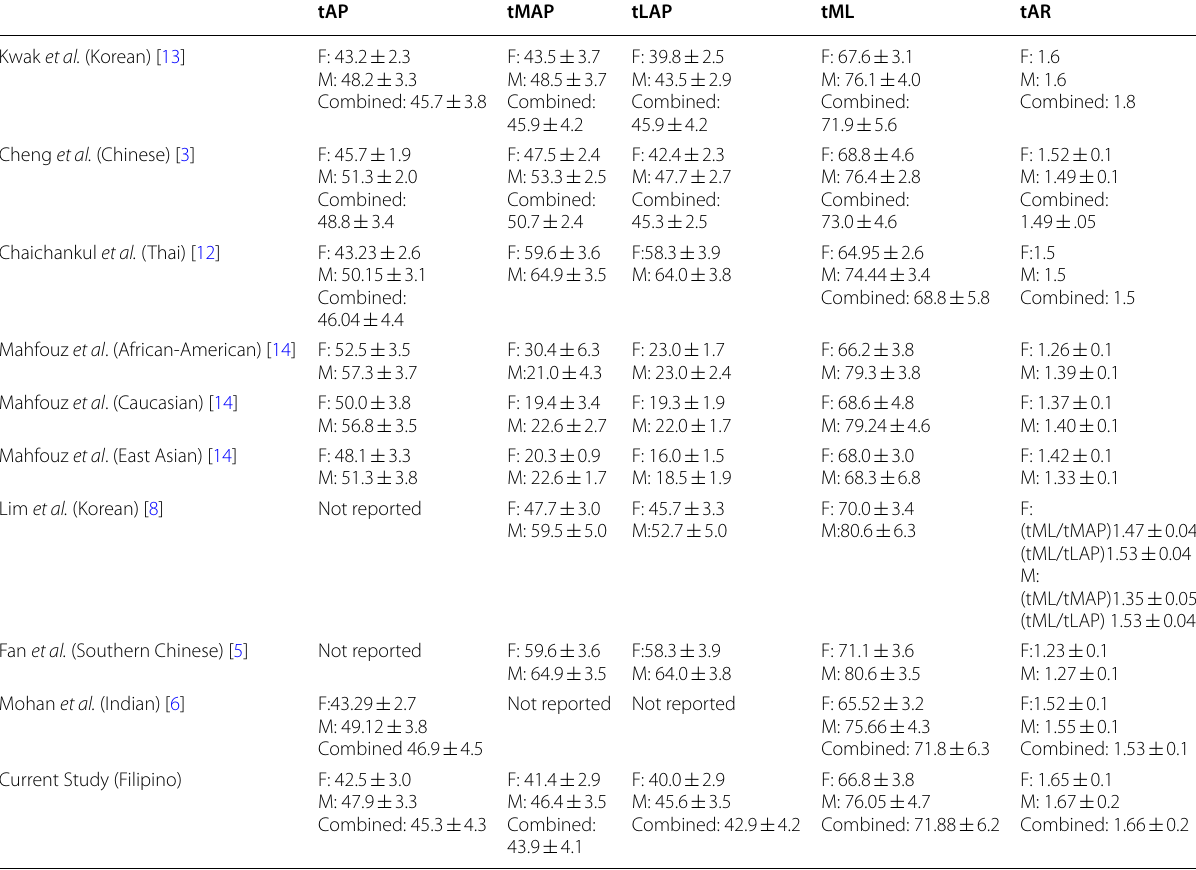
Table 9 Tibial morphometric parameters of different ethnicities (in millimeters) tAP tMAP tLAP tML tAR Kwak et al. (Korean) [13]